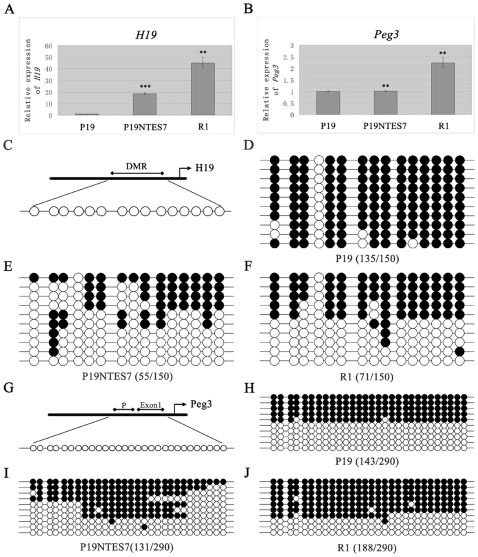
The expression analysis of H19, Peg3 and DNA methylation analysis of their specific DMRs.In order to understand the relationship between the induction of H19 and DNA methylation of its DMR, bisulfite genomic sequencing was performed among P19, P19 NTES7 and R1, with Peg3 as control. (A), (B) The expression analysis of H19 and Peg3 determined by quantitative PCR. Error bars depict standard deviation. ** p-value<0.01; *** p-value<0.001 (C) The CpG islands contained in DMR of H19 are shown schematically. (D), (E), (F) The bisulfite genomic sequencing results of H19 in P19, P19 NTES7 and R1 are shown. (G) The CpG islands contained in DMR of Peg3 are shown schematically. (H), (I), (J) The bisulfite genomic sequencing results of Peg3 in P19, P19 NTES7 and R1 are shown schematically. The black circle represents the methylated CpG island, the white circle represents the unmethylated CpG island.